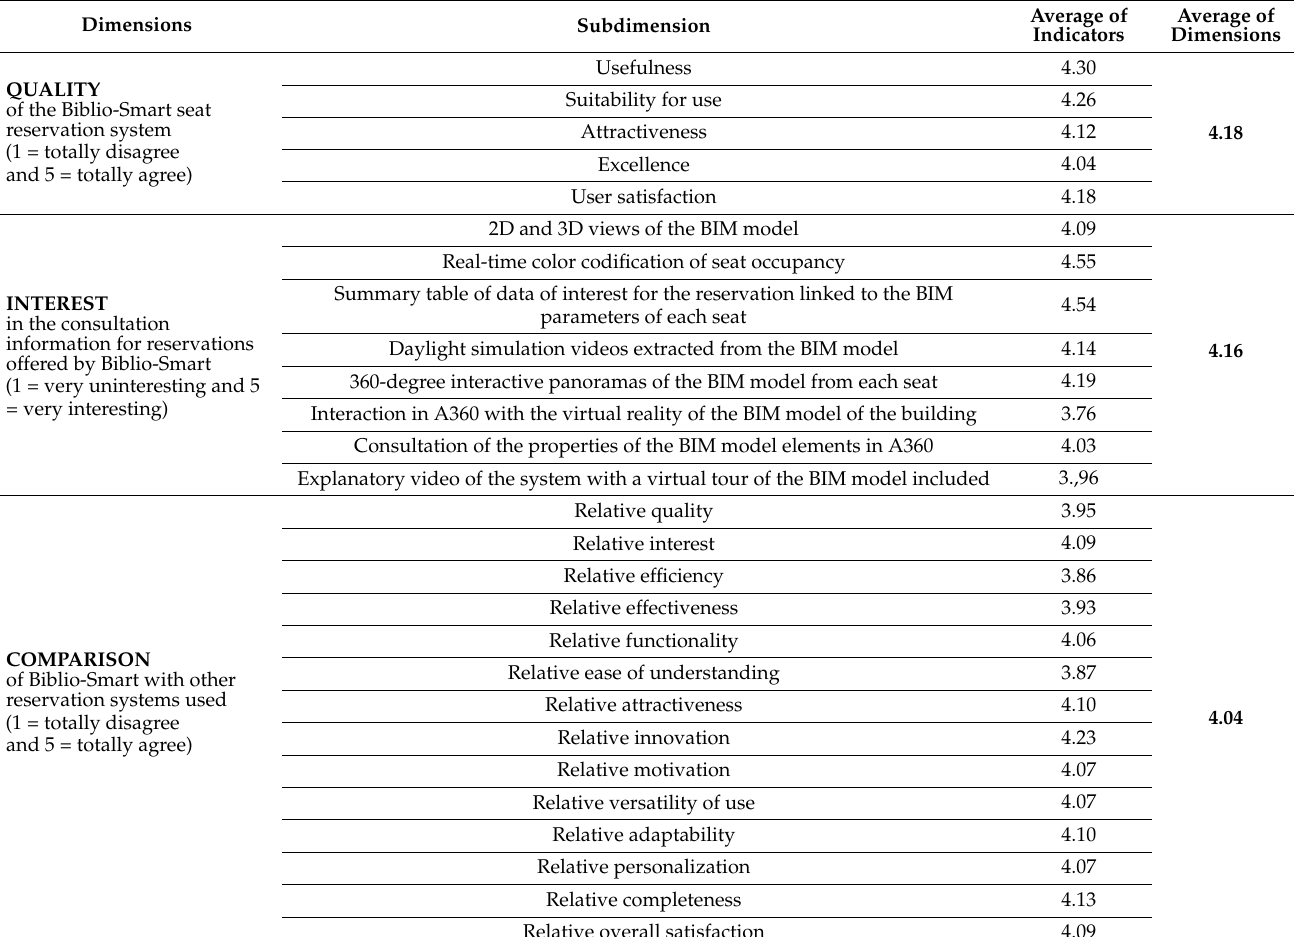
Table 6. Comparison of mean values obtained in each indicator and in each of the three main dimensions